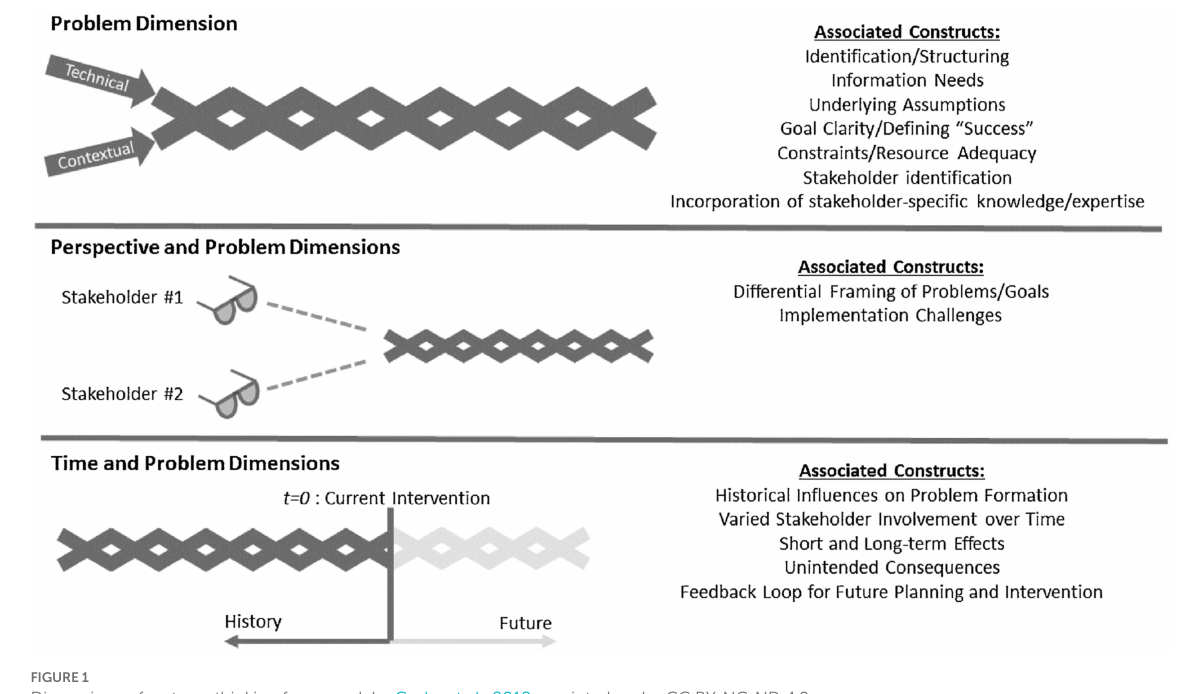
FIGURE 1 Dimensions of systems thinking framework by Grohs et al., 2018, reprinted under CC BY-NC-ND